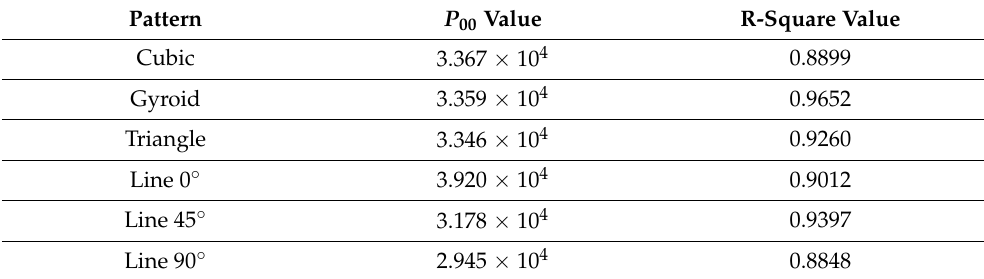
Table 8. Regression coefficients for MLR correlation between process parameters and